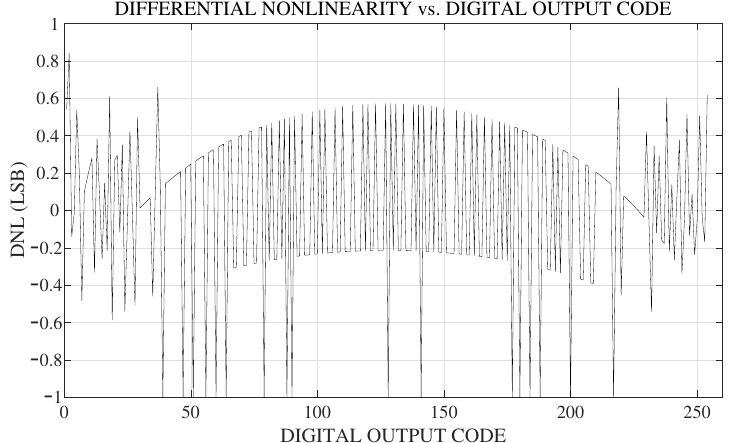
Figure 18. The DNL of the SAR ADC.